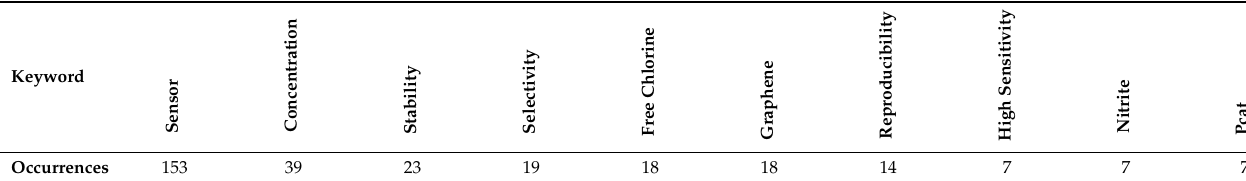
Figure 9. Cluster 5 Network—“water sample” main keyword. Table 8. Cluster 5 keywords and occurrences. Keyword